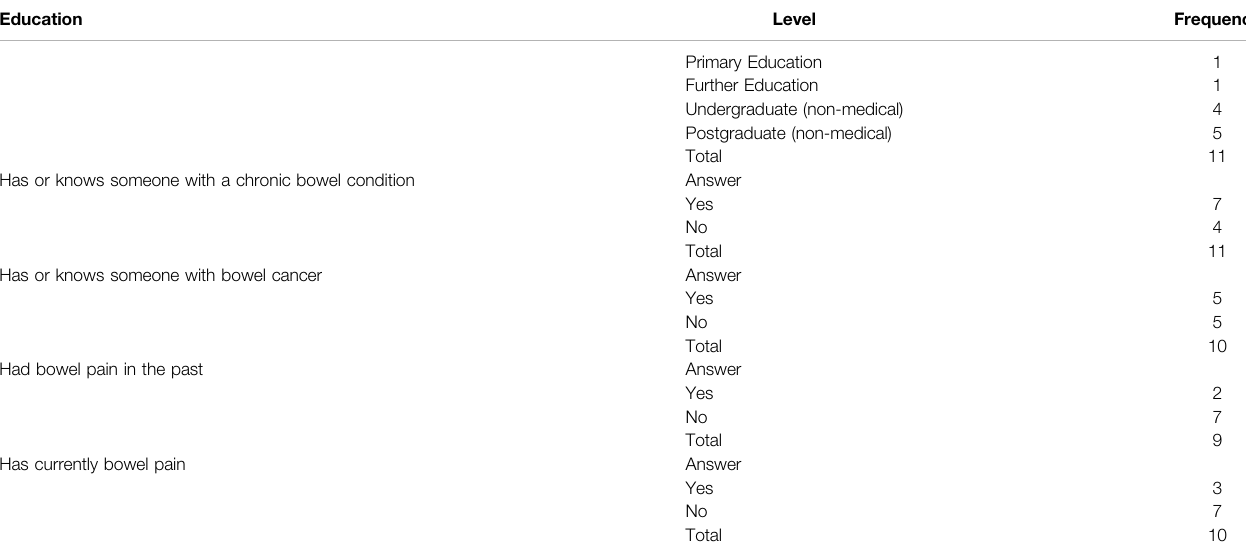
TABLE 1 | Interviewees ’